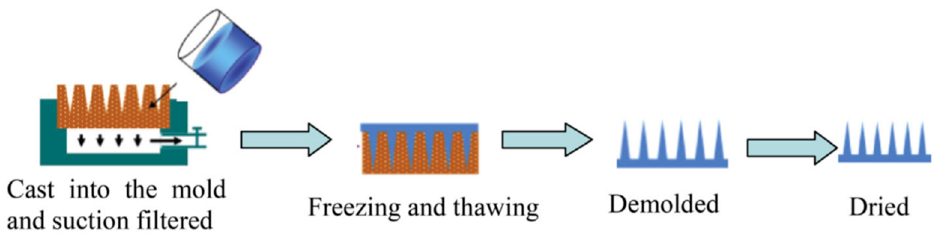
Figure 7. Polymeric MNs manufacturing using micro molding method, reproduced with permission from [150], Elsevier, 2016.